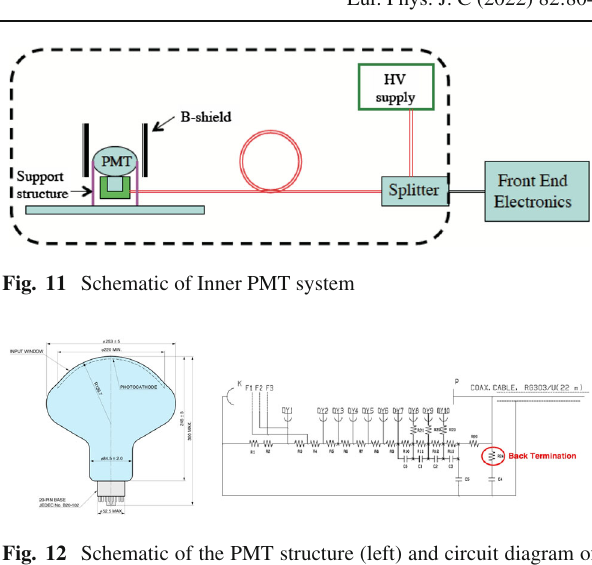
Fig. 12 Schematic of the PMT structure (left) and circuit diagram of the base